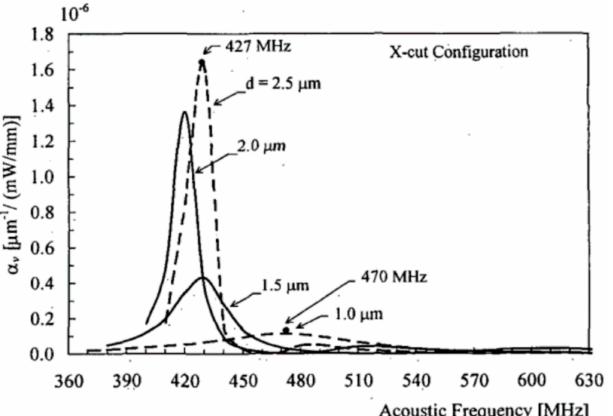
Figure 6. The radiation decay coefficient as a function of frequency for an x -cut leaky mode modulator. Reproduced with permission from [22] © IEEE.